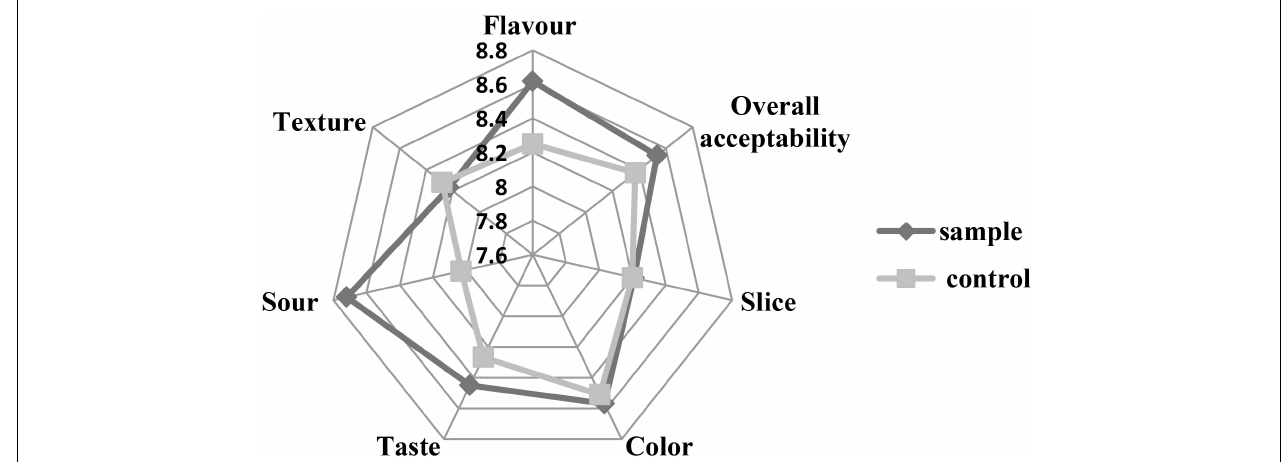
FIGURE 6 | The sensory analysis of the